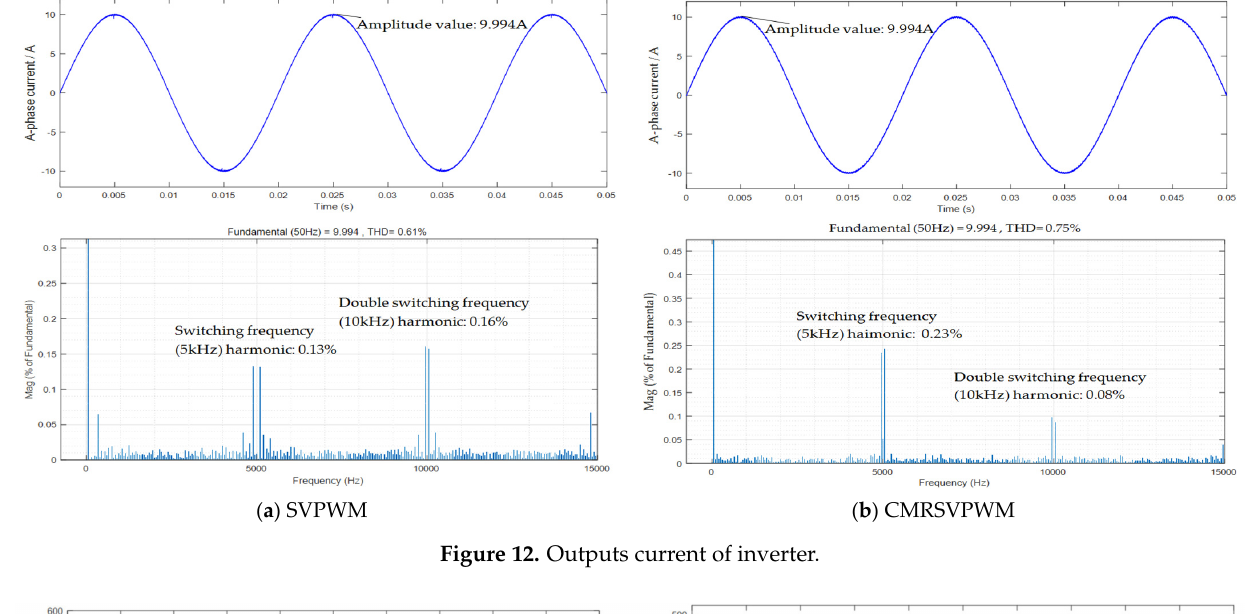
voltages are comparable for both.